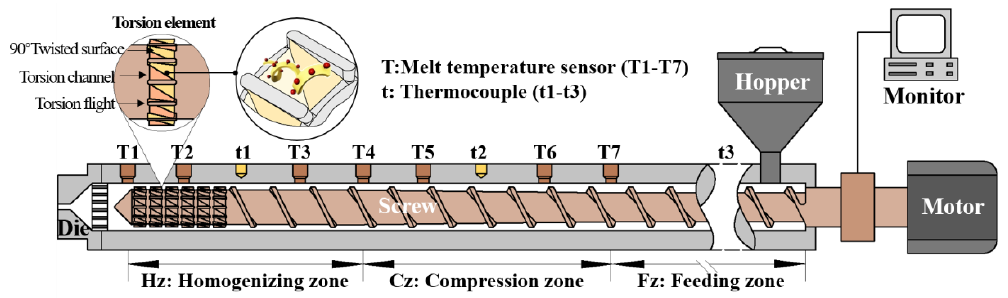
Figure 1. Test extruder (28D) employed in the experiments.